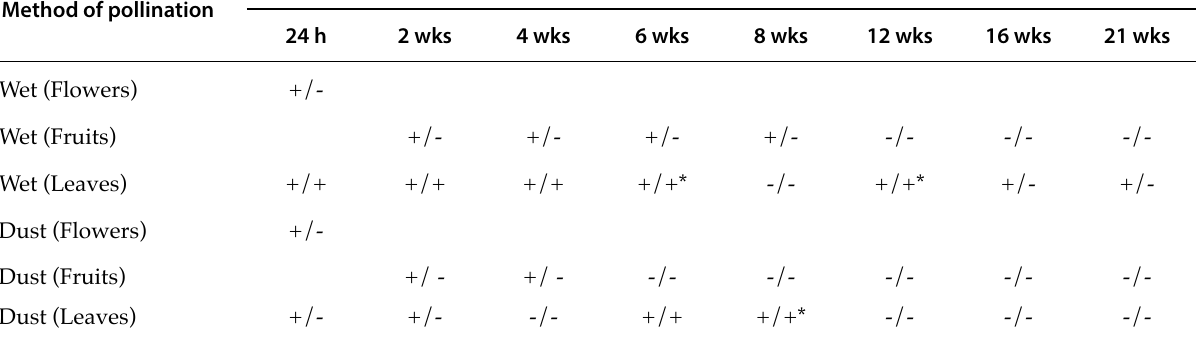
Table 2. Time of sampling and detection of Pseudomonas syringae pv. actinidiae (Psa) in field experiments after pollination (wet and dry) with naturally contaminated pollen in 2012. In 2013 pollination was natural and first sampling was taken at full bloom. Results shown summarise detection of Psa in two following growing seasons, 2012 and 2013. The epiphytic presence of Psa in 2013 was erratic and on leaves only. An asterisk indicates that symptoms associated with presence of Psa were detected on plants during the 2013